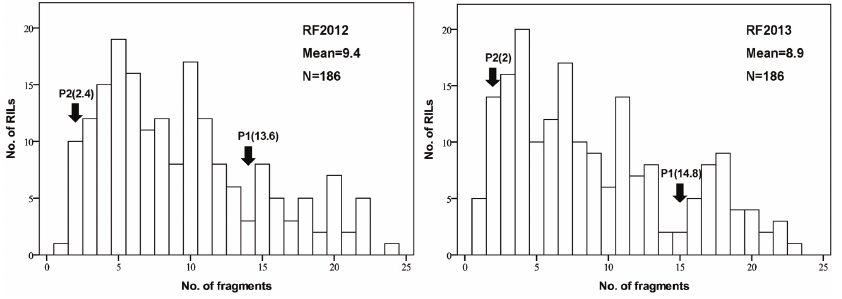
Figure 2. Frequency distributions of the number of average spike rachis fragments. RF2012 and RF2013 were obtained from crosses between Triticum aestivum ssp. tibetanum Shao population Q1028 6 ZM9023 established in 2012 and 2013, respectively. P1: Q1028, P2: ZM9023. RILs: recombinant inbred lines. Mean: average value of the trait. N: the number of